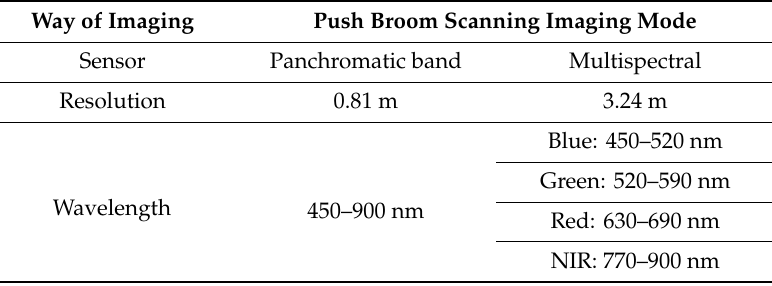
Table 1. Original data band settings.